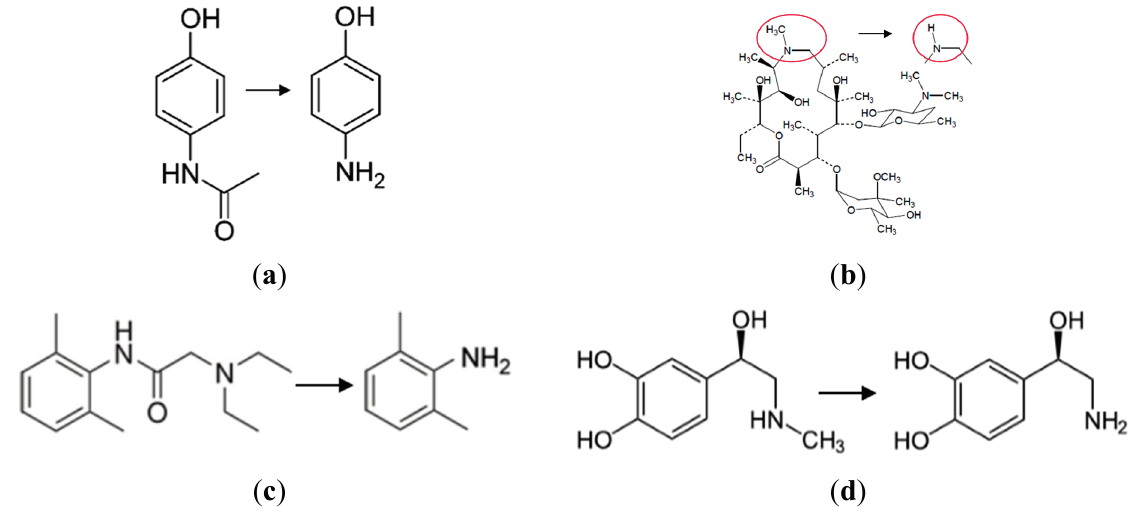
Figure 1. The chemical structures of the four drugs and their primary degradation products. ( a ) acetaminophen to p -aminophenol; ( b ) azithromycin to azaerythromycin A; ( c ) lidocaine to 2,6-dimethylaniline; and ( d ) epinephrine to nor-epinephrine.